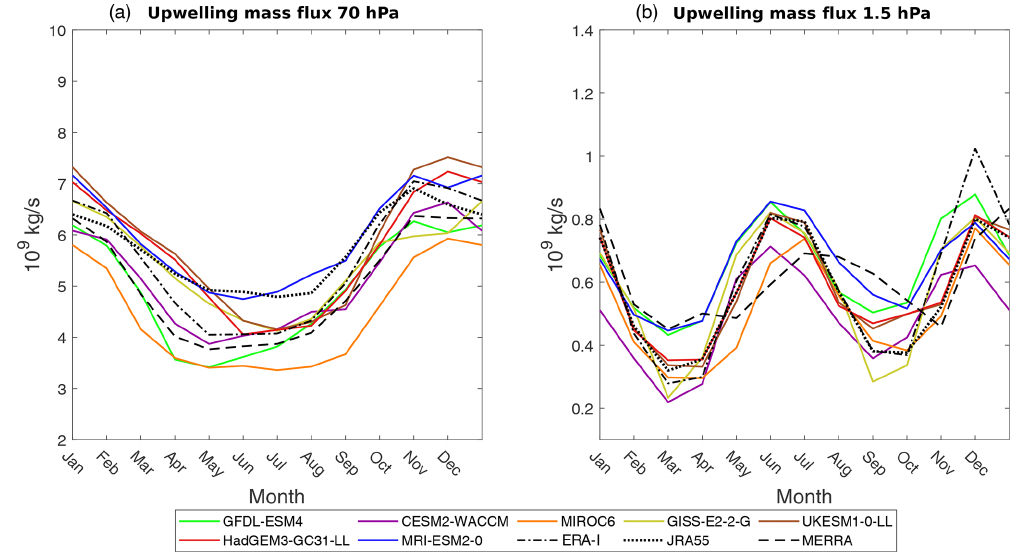
Figure 2. Seasonal cycle of tropical upwelling mass flux in the lower stratosphere (70hPa, a ) and in the upper stratosphere (1.5hPa, b ). Solid color lines show models, and dashed black lines show